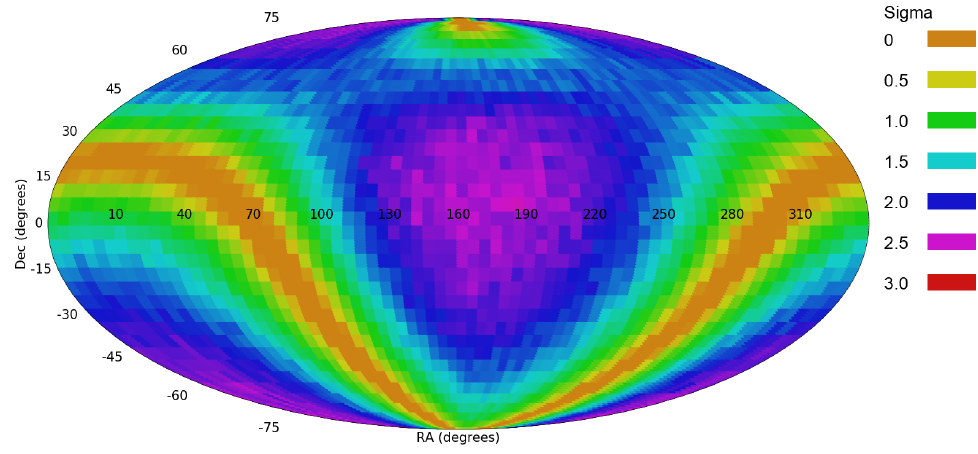
Figure 5. The χ 2 probability of a dipole axis in spin directions of the galaxies from different ( α , δ ) combinations, centered at ( α = 165 ◦ , δ = 40 ◦ ).